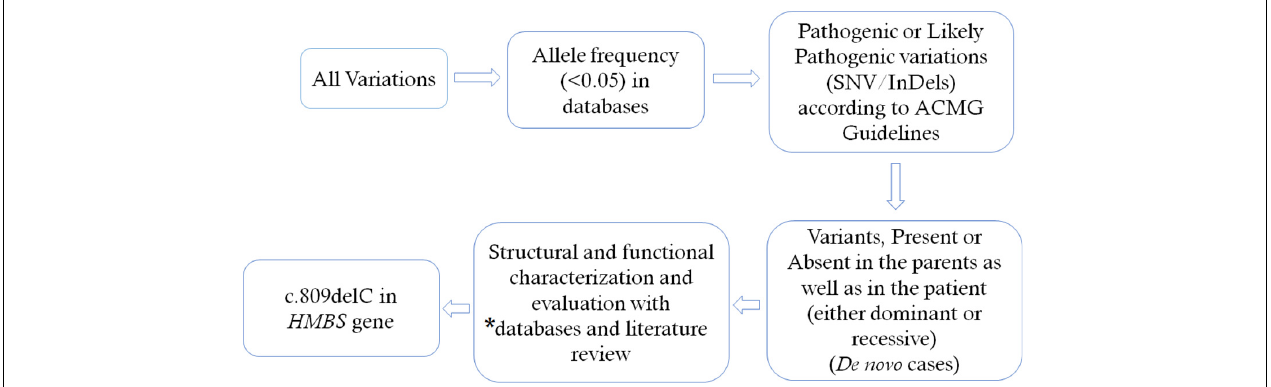
FIGURE 1 | Filtering process for pathogenic mutations in all variations obtained by exome sequencing. ∗ Databases used: dbSNP, Hapmap, 1000 Genomes Project and University’s in–house database of ∼ 500 Chinese people. SNV, single nucleotide variation: Indel, small insertion and deletion.